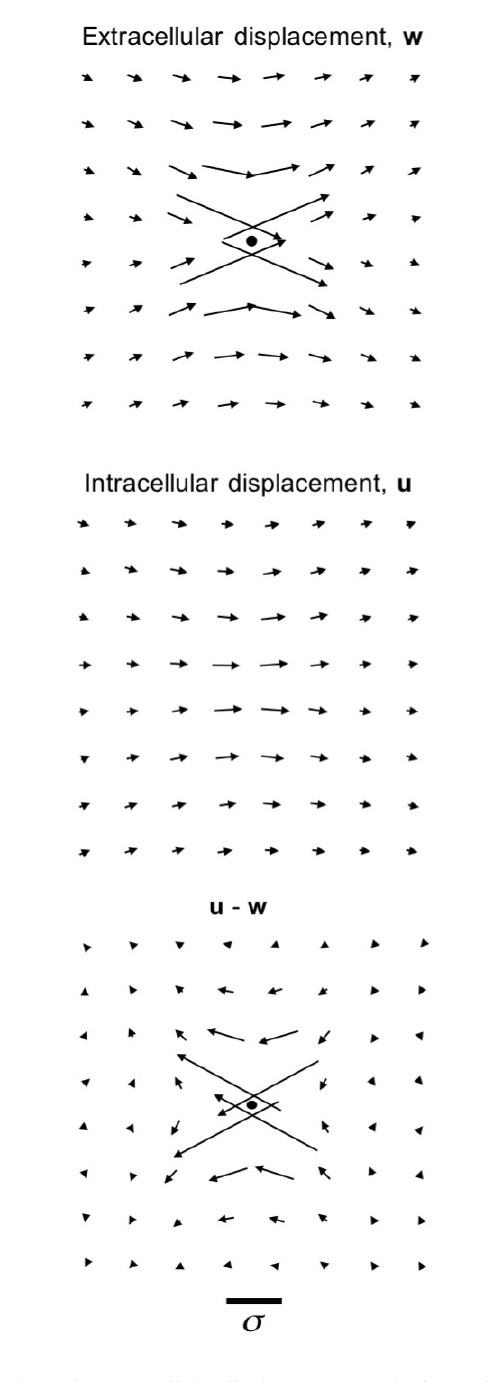
Fig. 2. The extarcellular displacement, w , the intracellular displacement, u , and their difference, u - w . The calculation assumes ν = µ . The black dot indicates the position of the point source, corresponding to an applied force F acting to the